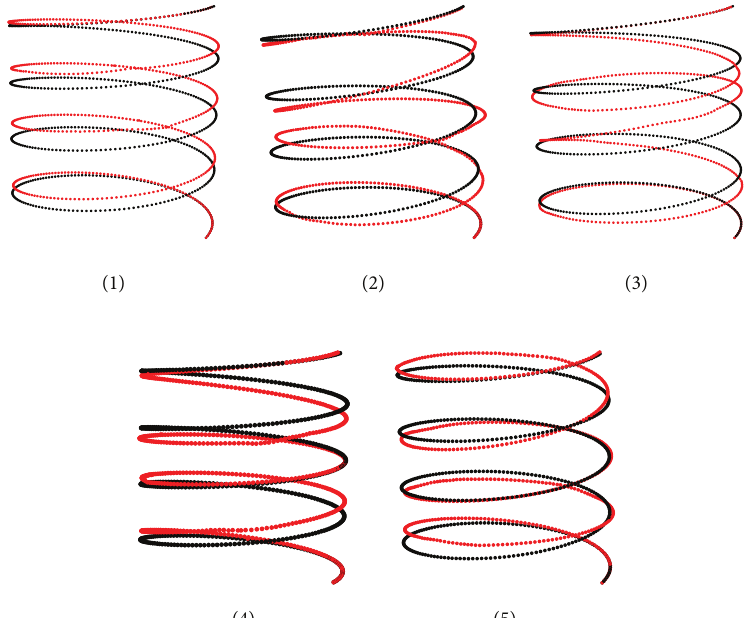
Figure 4: First five mode shapes of a die spring: (1) first mode (523.25 Hz); (2) second mode (897.71Hz); (3) third mode (914.36 Hz); (4) fourth mode (973.88 Hz); (5) fifth mode (1118.41Hz). Table 4: Change law of the warping effect on natural frequencies with respect to the diameter of the